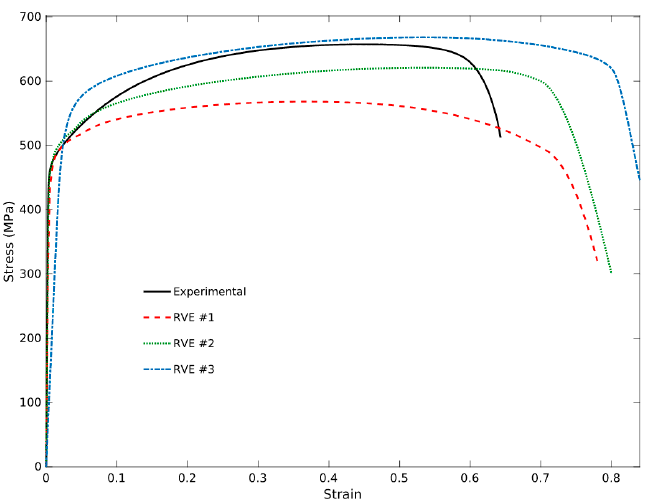
Figure 12. The influence of changing RVE size on engineering stress-strain curve.